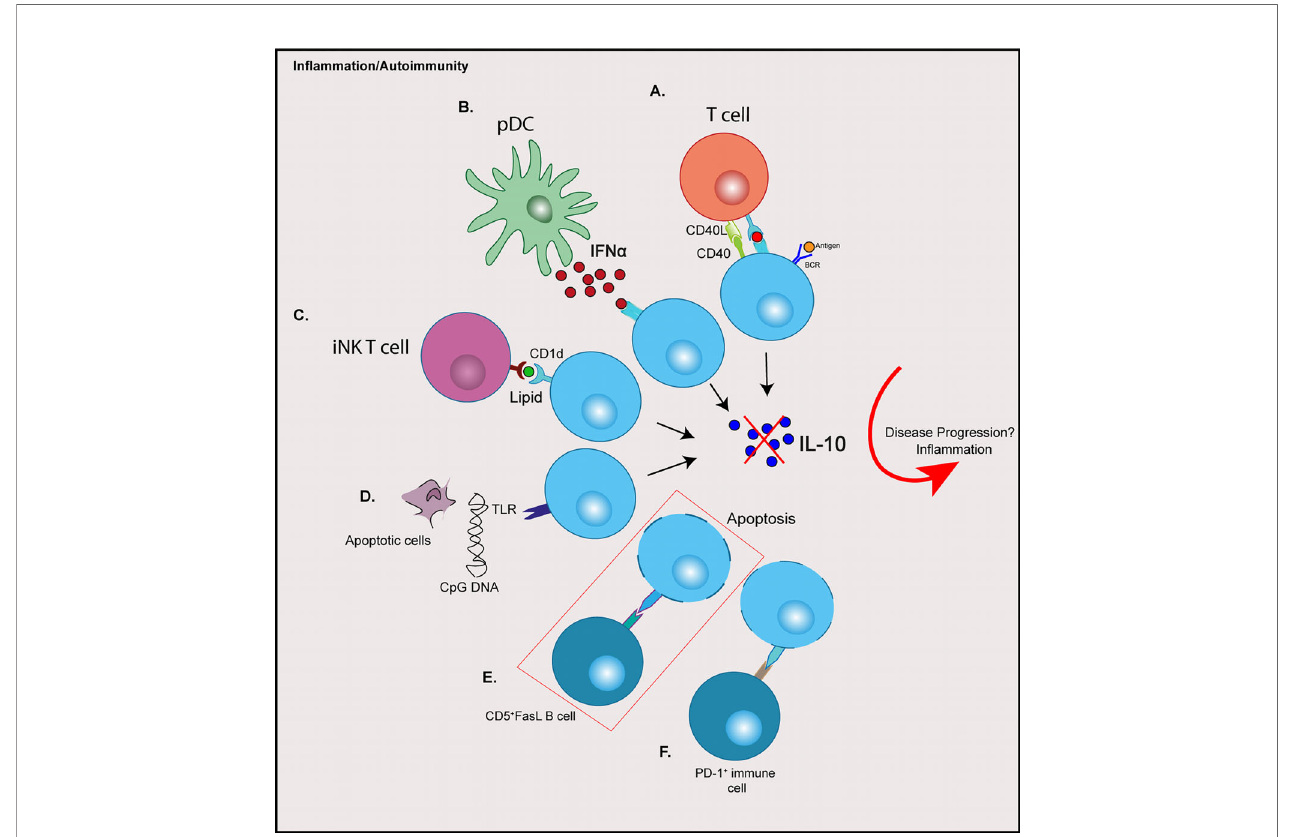
FIGURE 1 | Possible contributions of immune cell crosstalk resulting in dysregulation of regulatory B cells in type 1 diabetes. (A) Aberrant CD40:CD40L signalling through T cells (B) Elevated IFN a production from pDCs (C) Altered iNK T cells and CD1d expression on B cells (D) TLR signalling from apoptotic cell debris or the presence of viruses or microbes (E) Increased expression of Fas on IL-10 + B cells are targeted by CD5 + FasL B cells (F) PD-L1: PD-1 engagement resulting in increased Breg apoptosis. Red box depicts a possible mechanism reported in type 1 diabetes. CPG, cytosine-phosphate-guanine; BCR, B cell receptor; IFN, Interferon; iNK, invariant natural killer; pDCs, plasmacytoid dendritic cells; TLR, toll-like receptor; FasL, Fas-ligand; PD-L1, programmed death-ligand 1; PD-1, programmed cell death protein